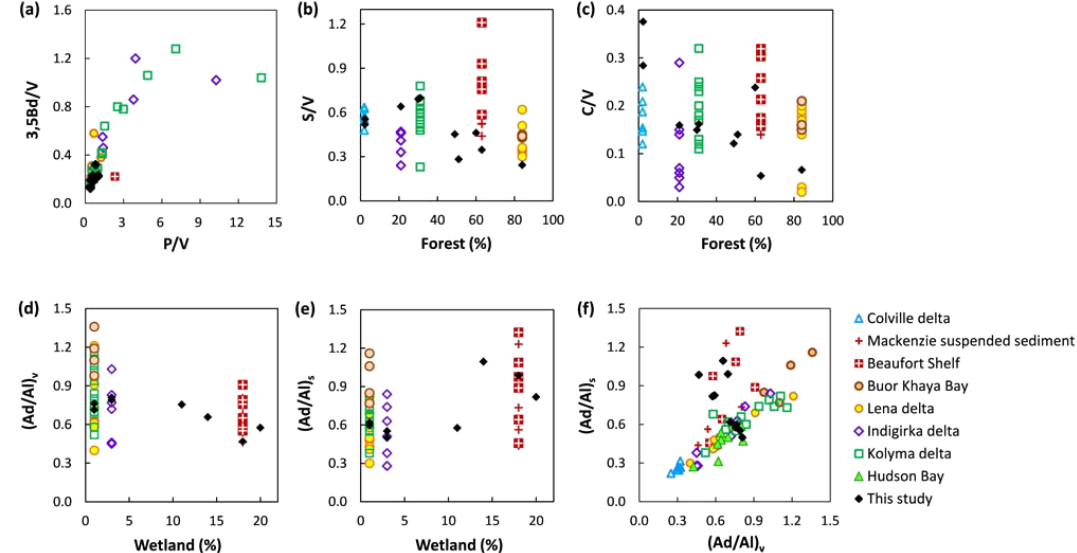
Figure 5. Comparisons of the lignin parameters from this study (black diamond) vs. published data in the pan-Arctic sediments (colored symbols). Original data are found in Schreiner et al. (2013) for Colville Delta sediments, Goñi et al. (2000, 2005) for Mackenzie River suspended sediments and Beaufort Shelf sediments, Winterfeld et al. (2015) for Buor-Khaya Bay sediments (receiving Lena River), Tesi et al. (2014) for Lena, Indigirka and Kolyma delta sediments and Kuzyk et al. (2008) for surface sediments of Hudson